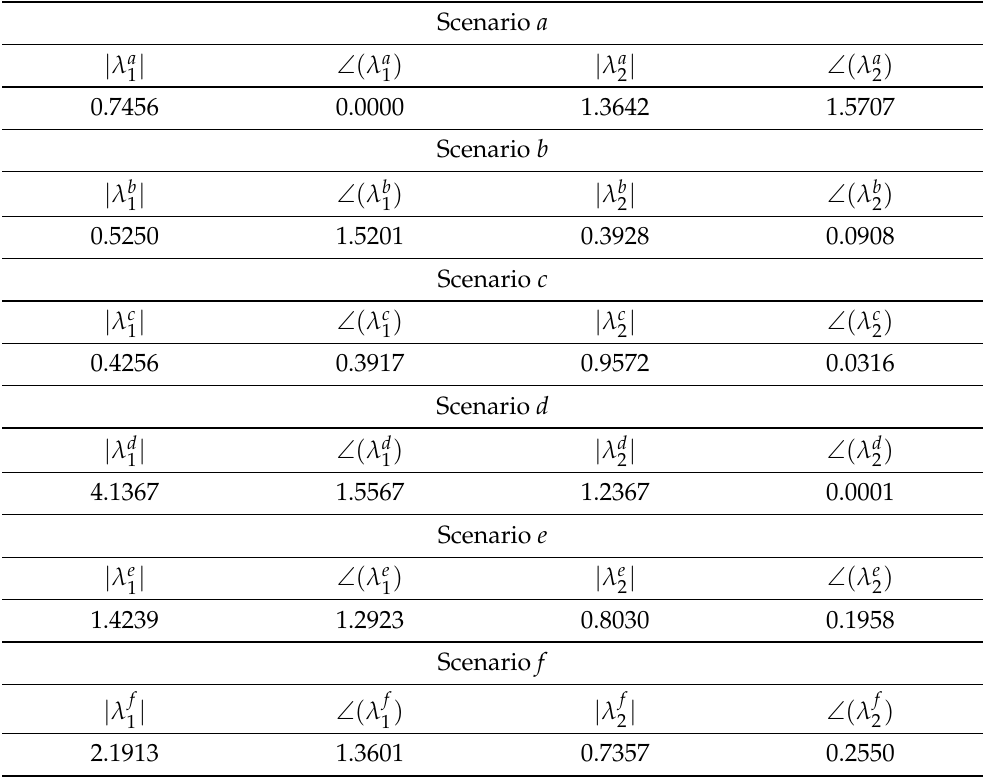
(among the values corresponding to our sampling) within each time t Table 3. Modulus and phase of the complex numbers λ i different scenarios i ∈ { a , . . . , f }